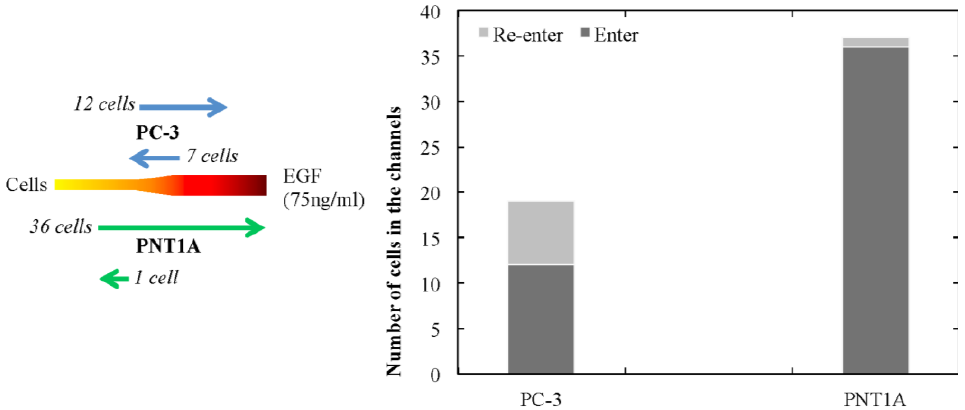
Figure 5. Comparison of the migration patterns between PC-3 and PNT1A when cells were seeded on the narrower end of the tapered channels. The arrows and numbers indicate the direction of cell migration and the number of cells. PC-3 cell re-entry is at a much higher rate than that for